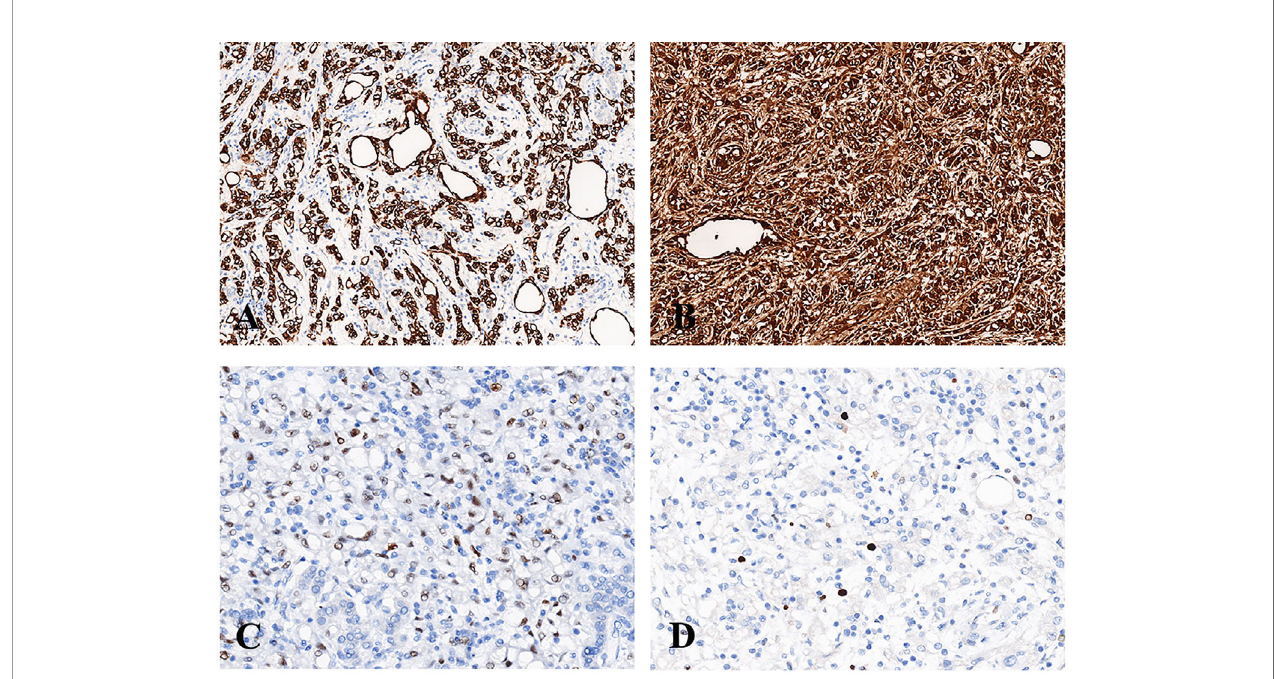
FIGURE 3 | Immunohistochemistry of adrenal AT. (A) The tumor cells were diffusely positive for AE1/AE3 (200×). (B) The tumor cells were diffusely positive for calretinin (200×). (C) The tumor cells were focally positive for WT-1 (400×). (D) The Ki-67 index was approximately 2%